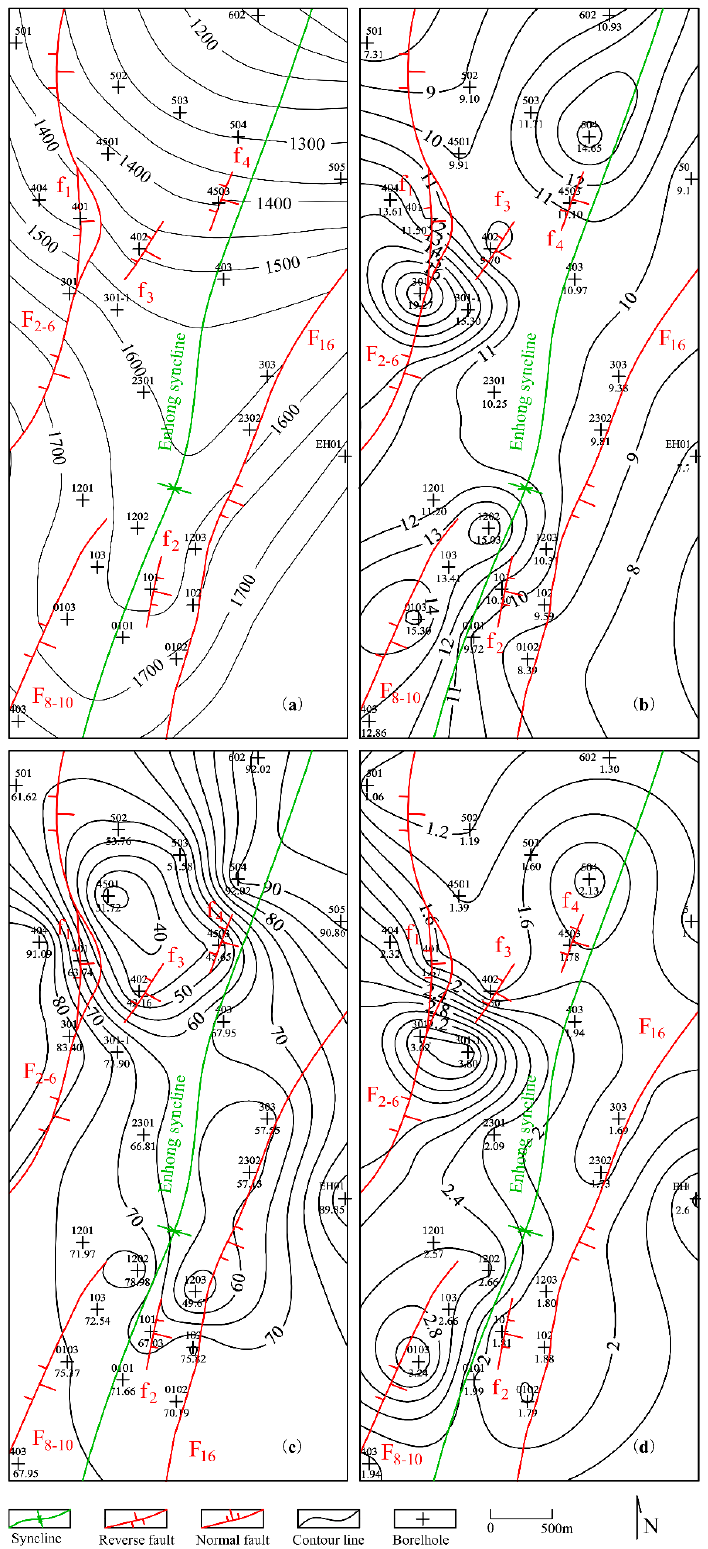
Figure 5. Contour maps of No. 9 coal seam floor, structural sketch and gas-bearing property parameters. ( a ) coal seam floor and structural sketch; ( b ) gas content; ( c ) methane concentration; ( d ) gas content gradient.